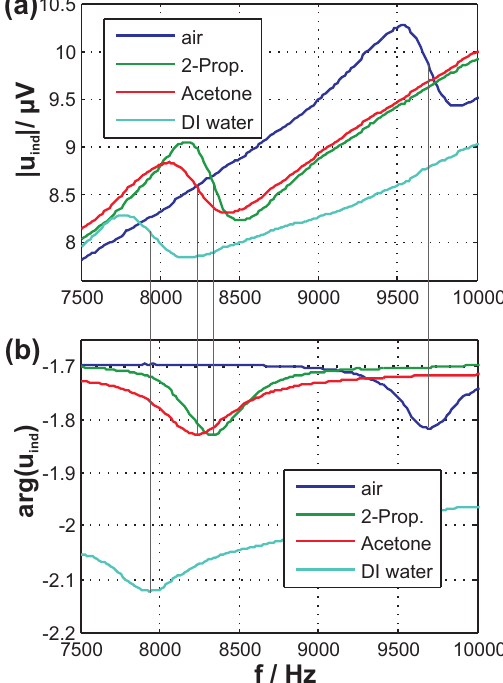
of the double-membrane sensor for various test